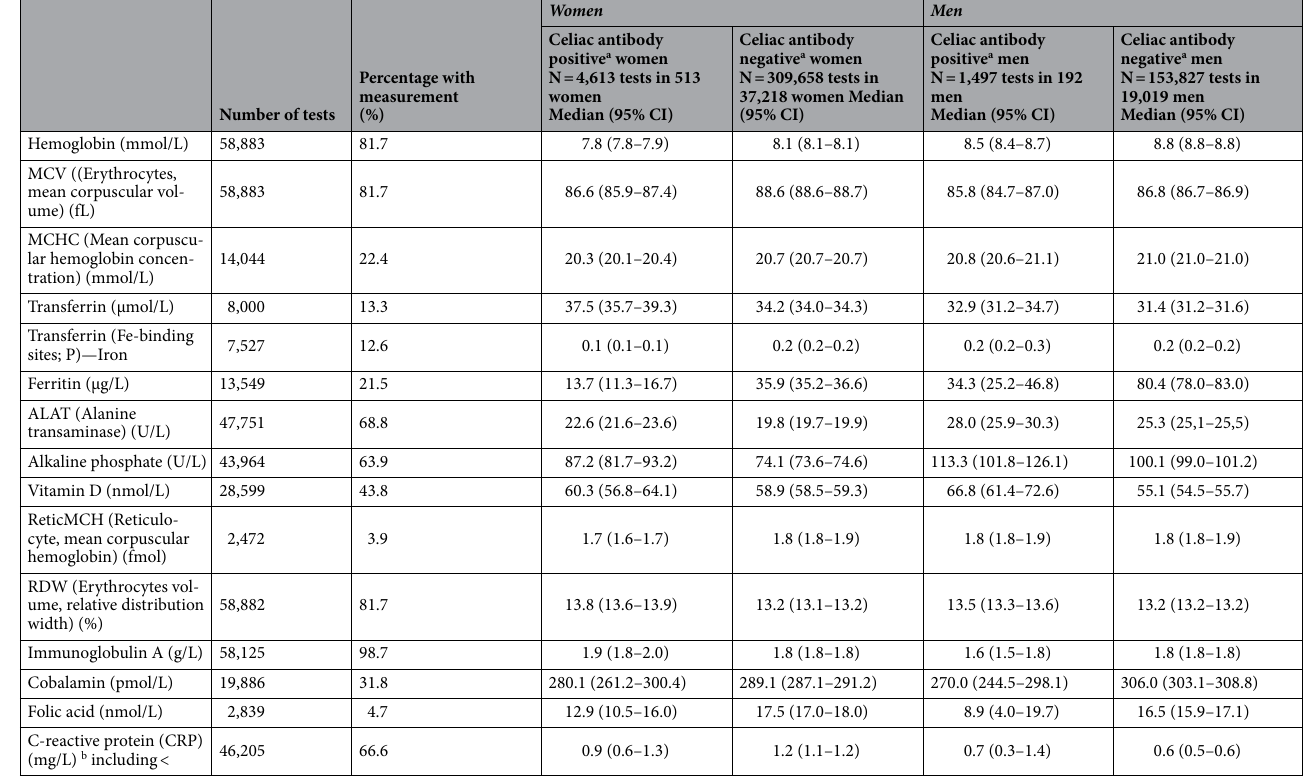
Table 3. Results of hematological and biochemical measurements during the period six months before to one month after blood drawing and testing among individuals with positive and negative celiac antibody tests. a A positive celiac antibody test was defined as: IgA/IgG TTG of at least 7 U/ml or IgG DGP of at least 10 U/ ml and a negative test was defined as IgA /IgG TTG under 7 U/ml and IgG DGP under 10 U/ml. b CRP was reported with ‘ < ’ in many cases; Low results were reported as < 5 mg/L (between December 2, 2002 and May 28, 2008) and < 4 (from May 29,